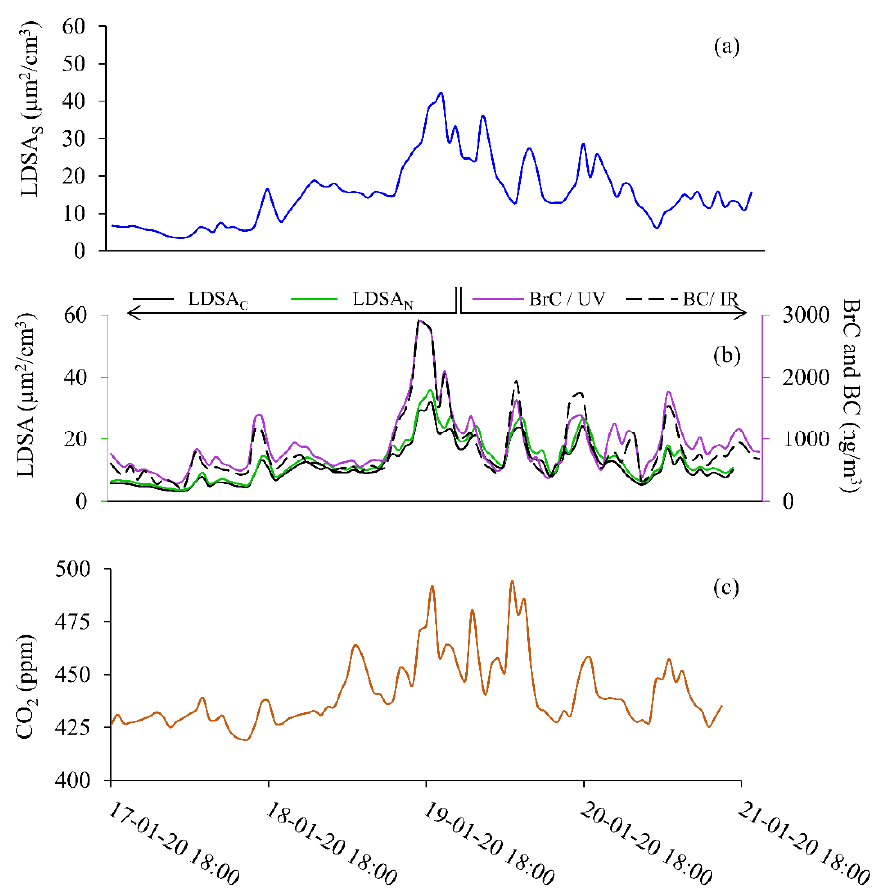
Figure 3. Solid particle event shown for 17 January 2020 at 18:00 to 21 January 2022 at 18:00 for ( a ) SMPS (LDSA S ), ( b ) LDSA N and LDSA C (left axis), BC and BrC (right axis), and ( c ) CO 2 .